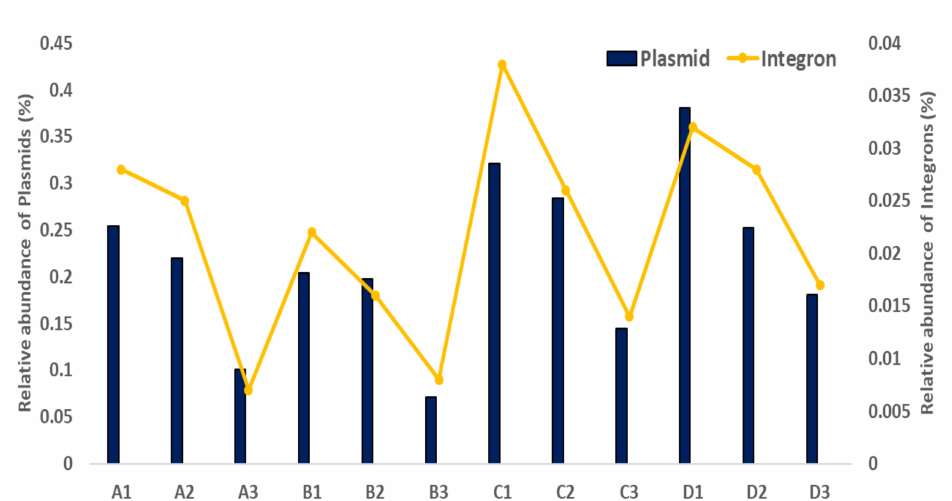
Figure 5. Relative abundance of mobile genetic elements, including plasmids and integrons, in the small (A, B) and large (C, D) WWTP samples. A1, B1, and C1 indicate influent samples, A2, B2, and C2 indicate activated sludge samples, and A3, B3, C3 indicate effluent samples.